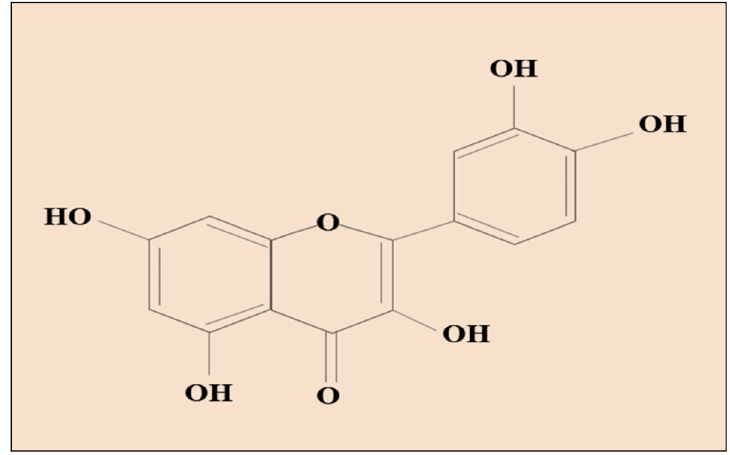
Figure 1. Chemical structure of quercetin [43].